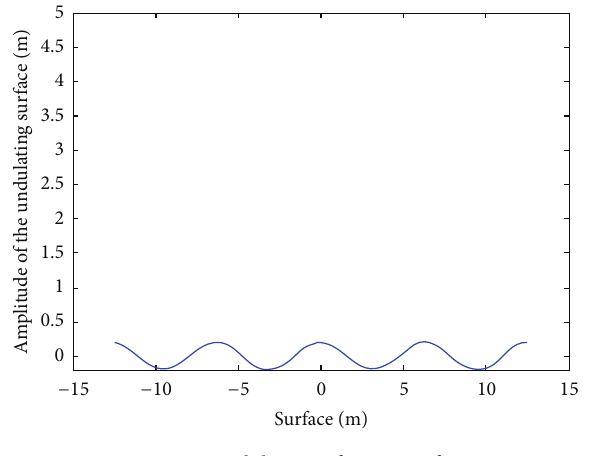
Figure 3: Undulating reference surface.